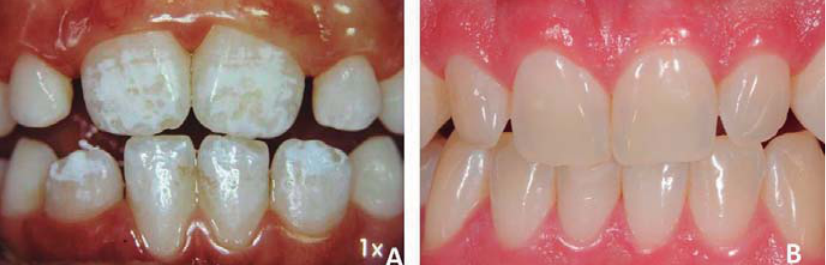
Figure 3- A: A 9-year-old boy with white enamel demineralization staining of six incisors; B: Twenty years after removal of the white stains on the maxillary central incisors by application of 18% hydrochloric acid and pumice; and after removal of white stains located on the mandibular teeth by application of the PREMA compound. The right mandibular lateral incisor presented a deep white stain; it was restored with resin-based composite